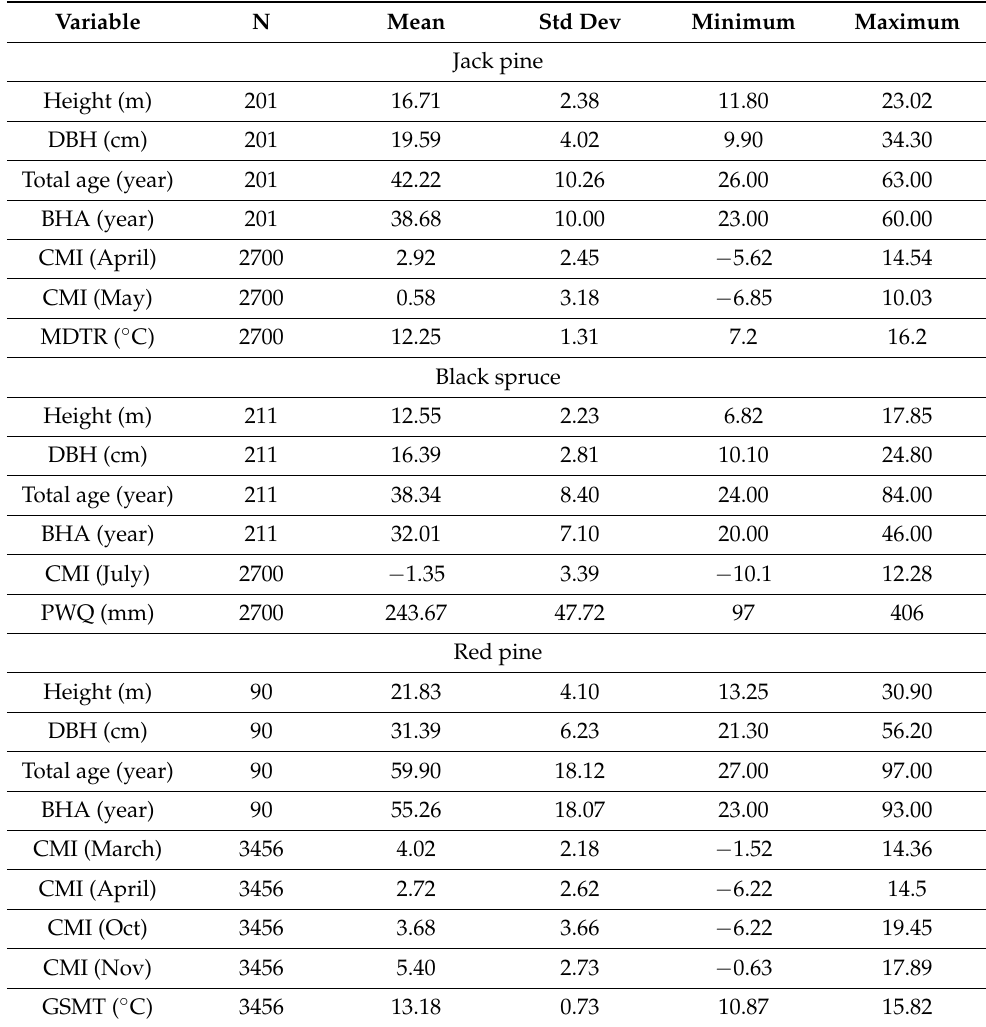
Table 1. Summary statistics (N = number of samples, Std Dev = standard deviation) for total height, diameter at breast height (DBH), total age, and breast height age (BHA) of plantation grown trees in Ontario, Canada and climate variables that best explained the variation in stand height growth of tree species used in this study. (CMI = climatic moisture index, MDTR = mean diurnal tempera- ture range, PWQ = precipitation of warmest quarter, GSMT = growing season mean temperature, AnMxT = annual maximum